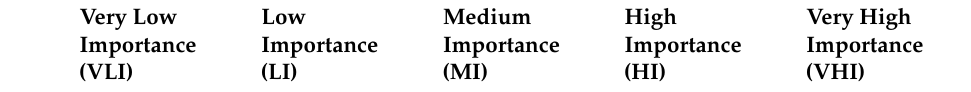
Table A1. Questionnaire used to know decision makers’ preferences for the identified